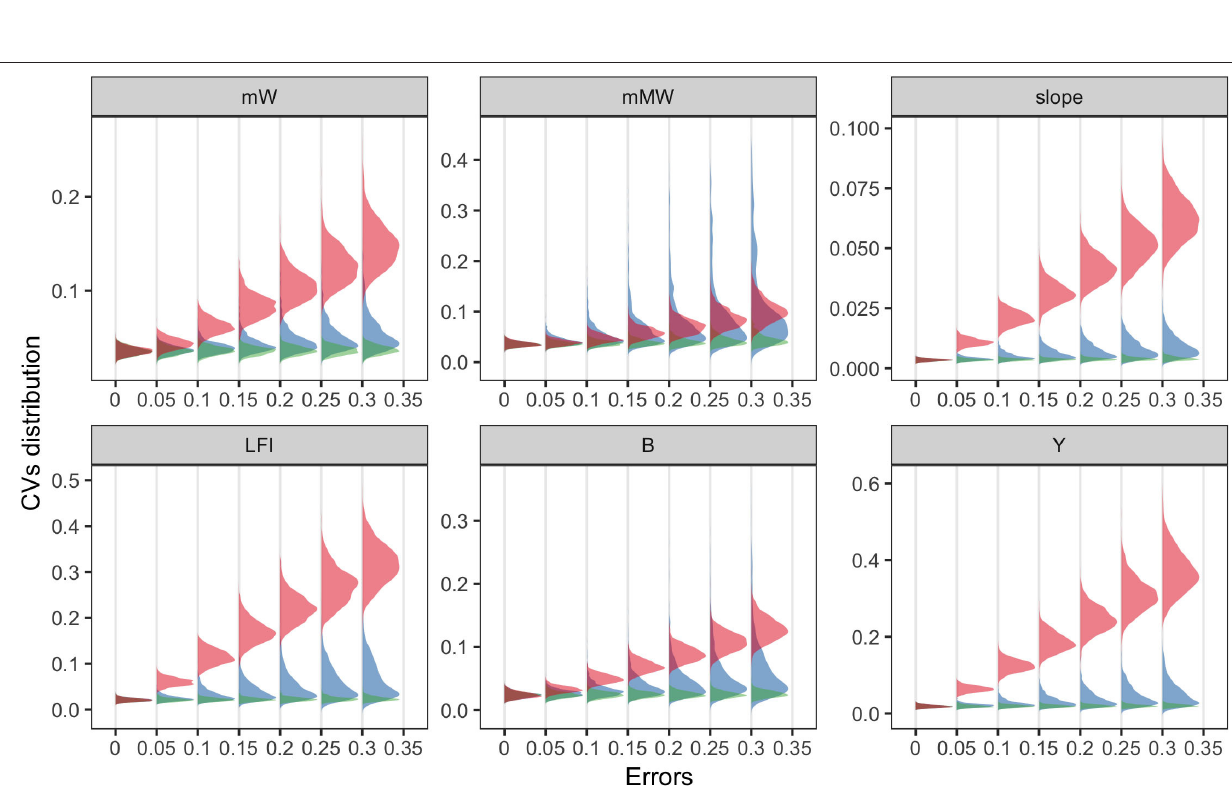
Frontiers in Marine Science | www.frontiersin.org